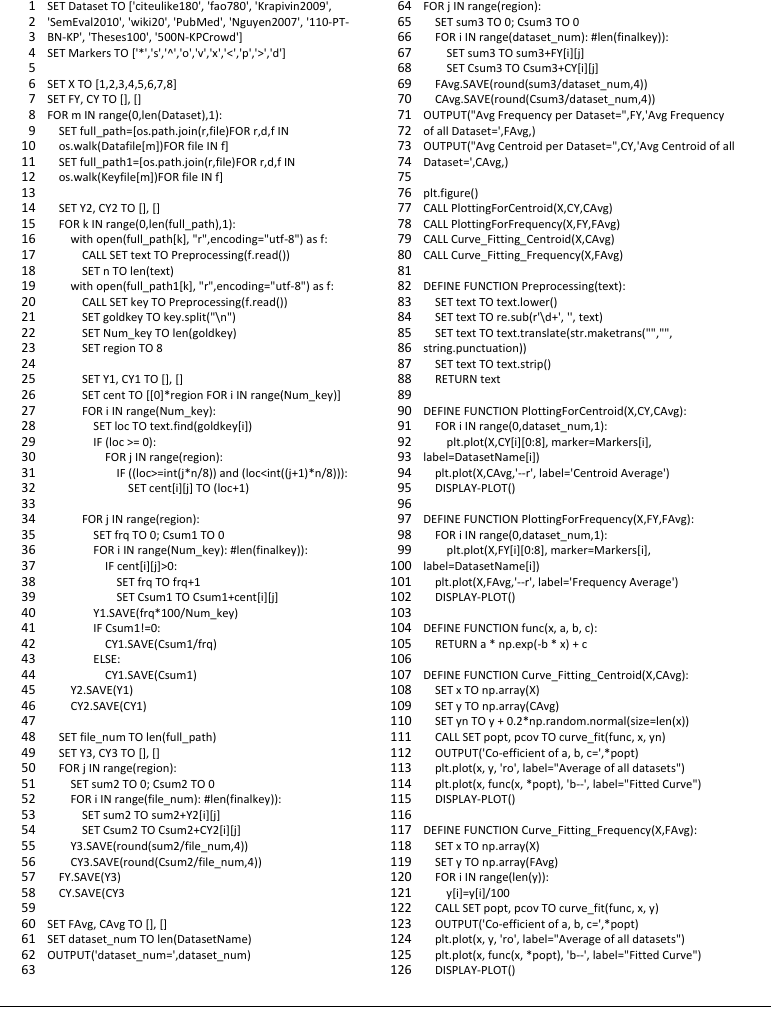
Figure 2. The pseudo code description of the proposed KCFA